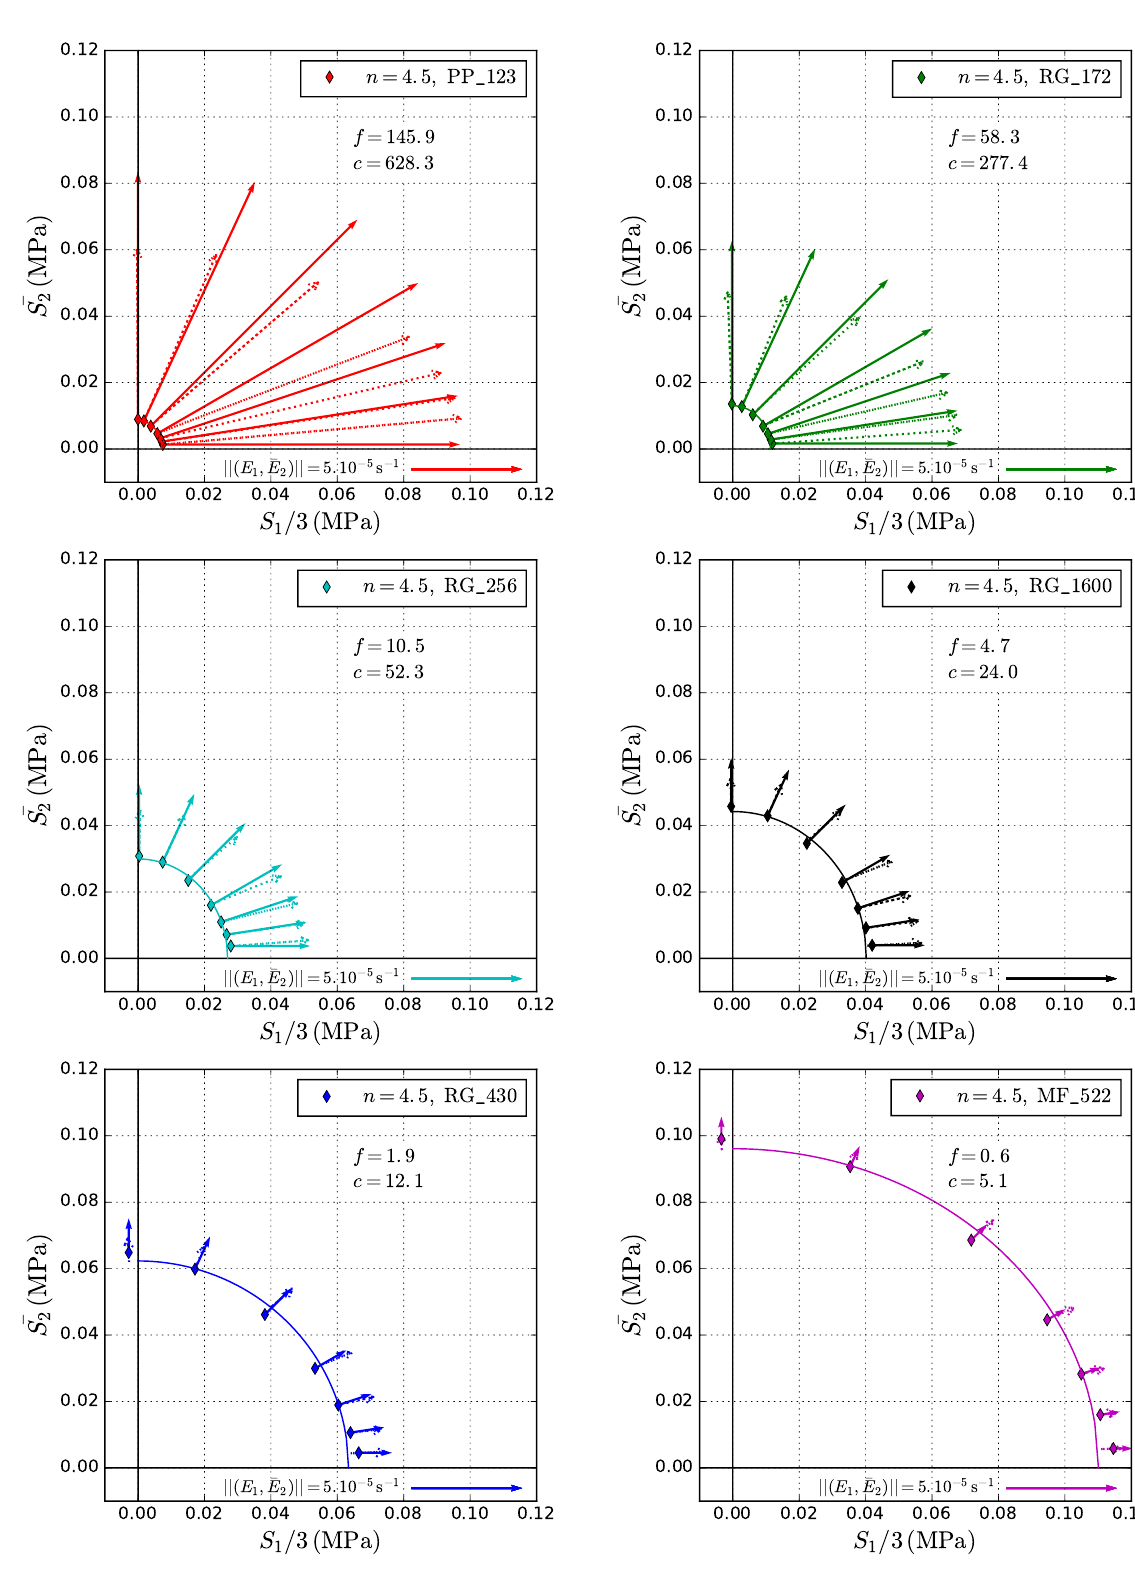
Figure 4. Iso-dissipation curves in the plane of the stress invariants (S 1 ,S 2 ) corresponding to n = 4 . 5 and to an arbitrary dissipated power P ◦ v for the six snow samples of Table 2 in increasing density order. The associated strain flow vectors (E ◦ arrows. Abouaf models are fitted to the numerical points (solid lines) and theoretical values of strain flow vectors are shown (dashed arrows). Parameters f and c of the fits are shown on the graphs and summarized in Table